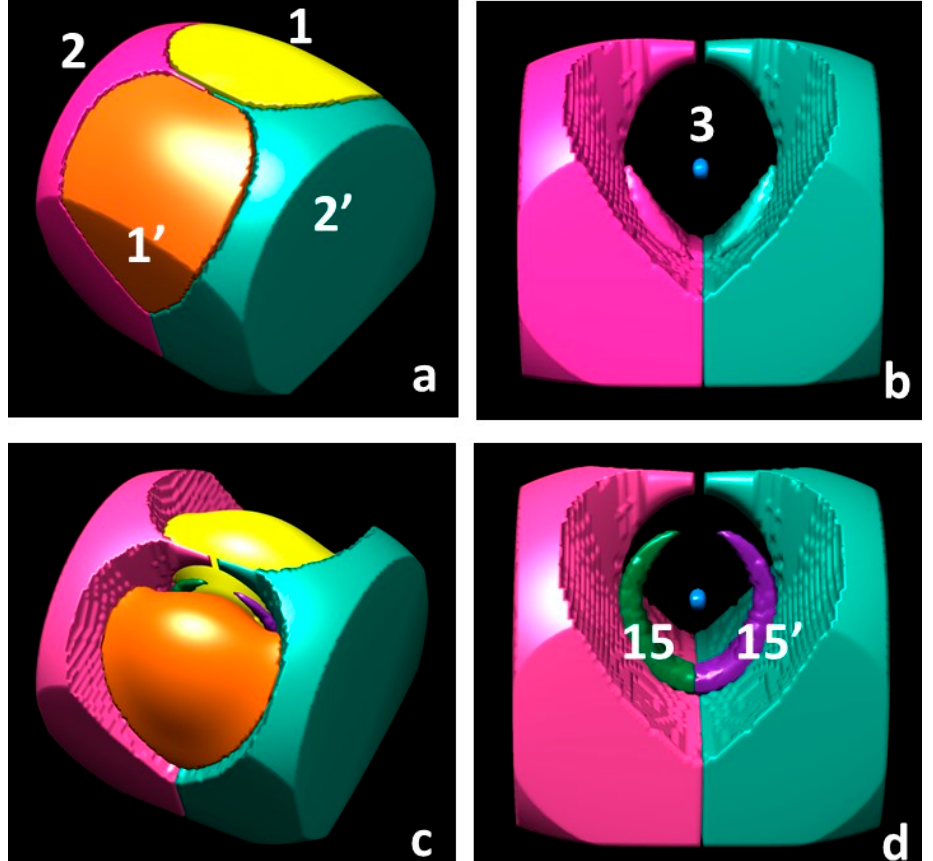
Figure 5. 3 B 1 H 2 O CAS spin density basins. The basins are labelled by their enclosed (3, − 3) spin maximum or, for the basin labelled 15, by its enclosed (3, + 3) spin minimum (see Tables 2 and 3). Each basin retains the same color in all illustrations. Panels a and b refer to basins bounded by local Zero–Flux Surfaces (ZFS) of ∇ s, while panels c and d to basins bounded by s = 0 isosurfaces (see text). Panel b ( d ) di ff ers from panel a ( c ) for the removal of basins 1 and 1’, so disclosing the small and embedded basin 3 around the O nucleus. Basins are represented through their spin density isovalue surfaces ((bohr) − 3 ): 0.0003 (basins 1,1’; ∇ s ZFS); 0.00009 (basins 1,1’; s = 0); 0.00031 (basins 2,2’); 0.0751 (basin 3); − 0.000017 (basins 15, 15’). The drawings in the four panels were performed with